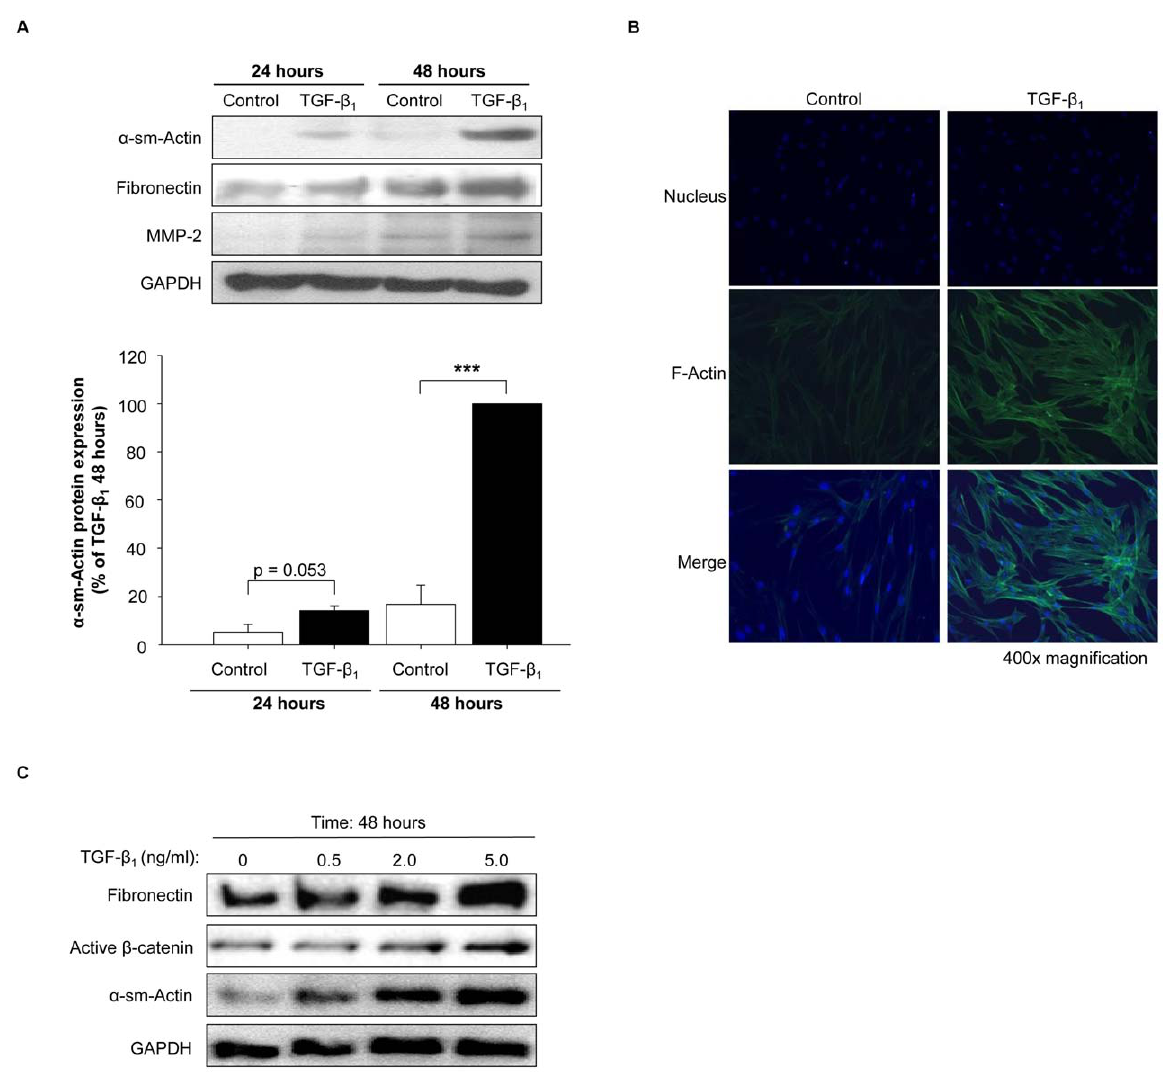
Figure 3. TGF- b 1 induces myofibroblast differentiation of MRC-5 lung fibroblasts. MRC-5 fibroblasts were grown to confluence and treated for 24 h or 48 h with 2 ng/ml of TGF- b 1 . (A) Expression of the myofibroblasts markers a -sm-actin, fibronectin and MMP-2 was evaluated in whole cell lysates by immunoblotting using specific antibodies. Equal protein loading was verified by the analysis of GAPDH. Representative immunoblots of 5– 8 independent experiments are shown. ***p , 0.001, two-way student’s t -test for paired observations. (B) Evaluation of stress fiber formation in MRC-5 lung fibroblasts after TGF- b 1 stimulation. MRC-5 lung fibroblasts were treated for 48 h with TGF- b 1 (2 ng/ml) and subsequently fixed and permeabilized. Cells were stained for filamentous actin (488 phalloidin; green) and nucleus (Hoechst 3342; blue). Pictures were taken at 400 6 magnification. (C) Effect of increasing concentrations TGF- b 1 on myofibroblast differentiation. MRC-5 fibroblasts were stimulated with 0.5, 2.0 and 5.0 ng/ml TGF- b 1 for 48 h. Expression of a -sm-actin, fibronectin and active b -catenin was evaluated in whole cell lysates by immunoblotting using specific antibodies. Equal protein loading was verified by the analysis of GAPDH. Representative immunoblots of 4 independent experiments are